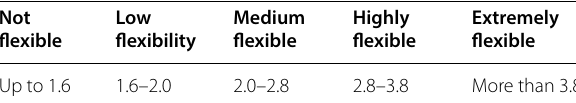
Table 1 Division of engines in terms of flexibility [1]